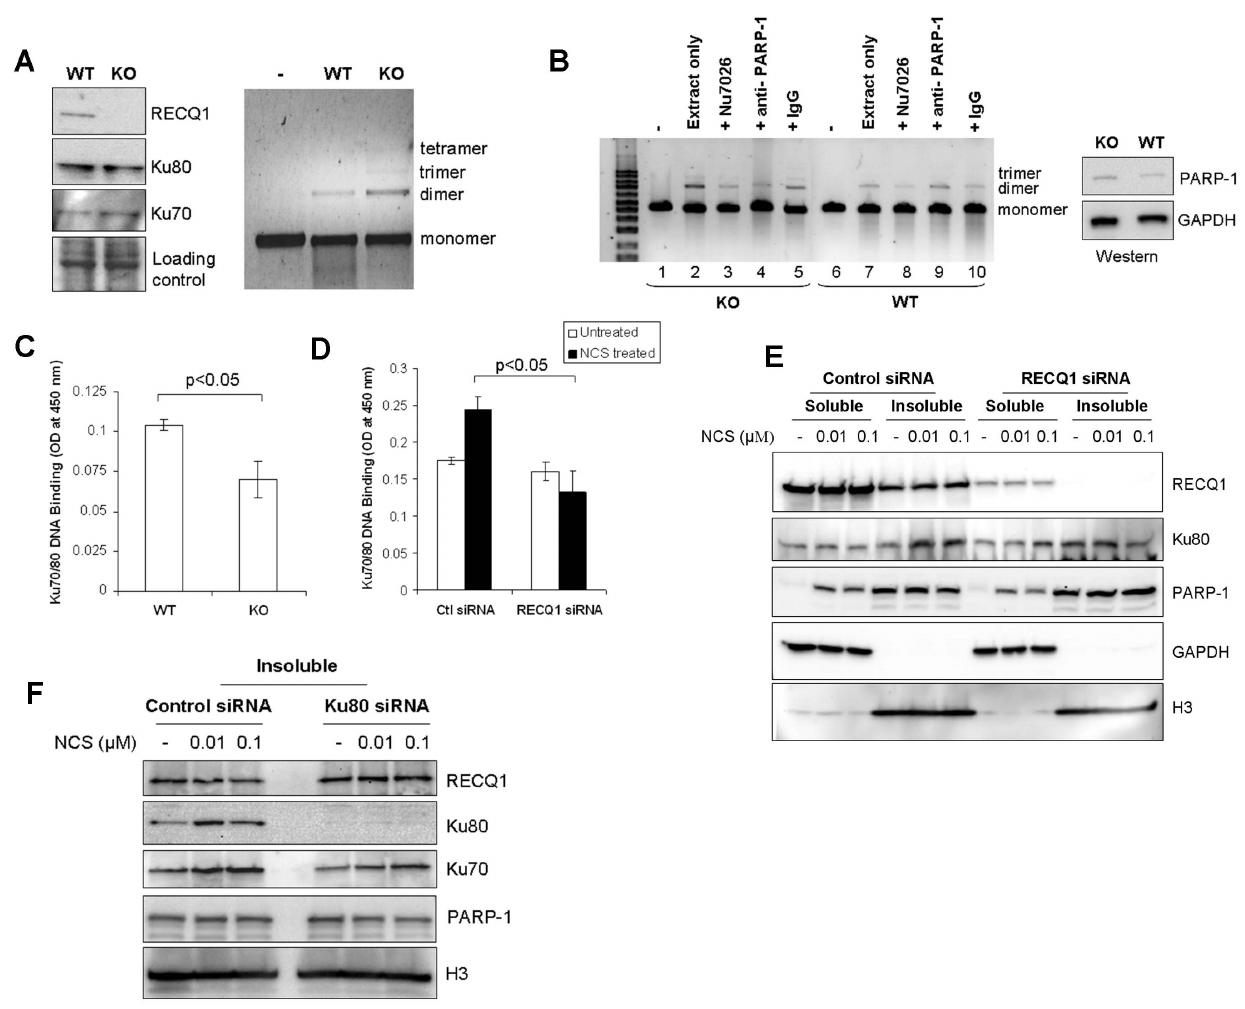
Figure 6. RECQ1-null cells promote end-joining but show reduced Ku-DNA binding activity. A. Level of in vitro end-joining activity is comparable in WT and RECQ1 KO MEFs. Cell free extracts prepared from non-transformed RECQ1 WT or KO MEFs were used in end-joining reaction containing EcoRI-linearized pUC19 DNA as substrate. Linear substrate DNA is indicated as monomer, and the end-joined products corresponding to dimer, trimer and tetramer are indicated (right panel). Western blot showed no detectable difference in Ku protein level in WT and KO cell extracts (left panel). GAPDH serves as loading control. B. Presence of PARP-1 antibody interferes with RECQ1 KO cell free extract mediated end-joining. In addition to standard reactions, in vitro end-joining reactions were performed with WT or KO cell extracts in the presence of a DNA-PKcs inhibitor Nu7026 (1.2 m M) or a specific anti-PARP-1 antibody (3 m g). IgG (3 m g) was included as unrelated antibody in a control reaction. Linear substrate DNA is indicated as monomer, and the end-joined products corresponding to dimer and trimer are indicated. Western blot showed no detectable difference in PARP-1 protein level in WT and KO cell extracts (left panel). GAPDH serves as loading control. C. Ku70/80 DNA binding assay performed by using Active Motif kit shows diminished DNA binding in RECQ1 KO extract as compared to WT extract (p , 0.05). The results shown are the average of at least three independent experiments, with SD indicated by error bars. D. DNA binding analysis for Ku70/80 in extracts prepared from control or RECQ1-depleted HeLa cells. Nuclear extracts prepared from control or RECQ1 siRNA transfected cells either untreated or treated with NCS (0.01 m M, 3 h) were used to perform Ku70/80 DNA binding assay (Active Motif). Following NCS treatment, RECQ1 siRNA transfected cells showed significantly reduced Ku70/80 DNA binding activity as compared to control siRNA transfected cells (p , 0.05). The results shown are average of at least three independent experiments, with SD indicated by error bars. E. RECQ1-depleted HeLa cells show reduced chromatin bound Ku following NCS treatment. Ku80 and PARP-1 was detected by Western blot in the soluble and insoluble fractions prepared from control or RECQ1 siRNA transfected cells that were either untreated or treated with indicated dose of NCS for 3 h. GAPDH serves as cytoplasmic marker and H3 serves as marker for chromatin enriched fractions. F. RECQ1 protein in the chromatin enriched fraction of control or Ku80-depleted cells. Cells were untreated or treated with indicated dose of NCS for 3 h, followed by biochemical fractionation and the chromatin containing insoluble fractions were examined by Western blotting. H3 serves as marker for chromatin enriched